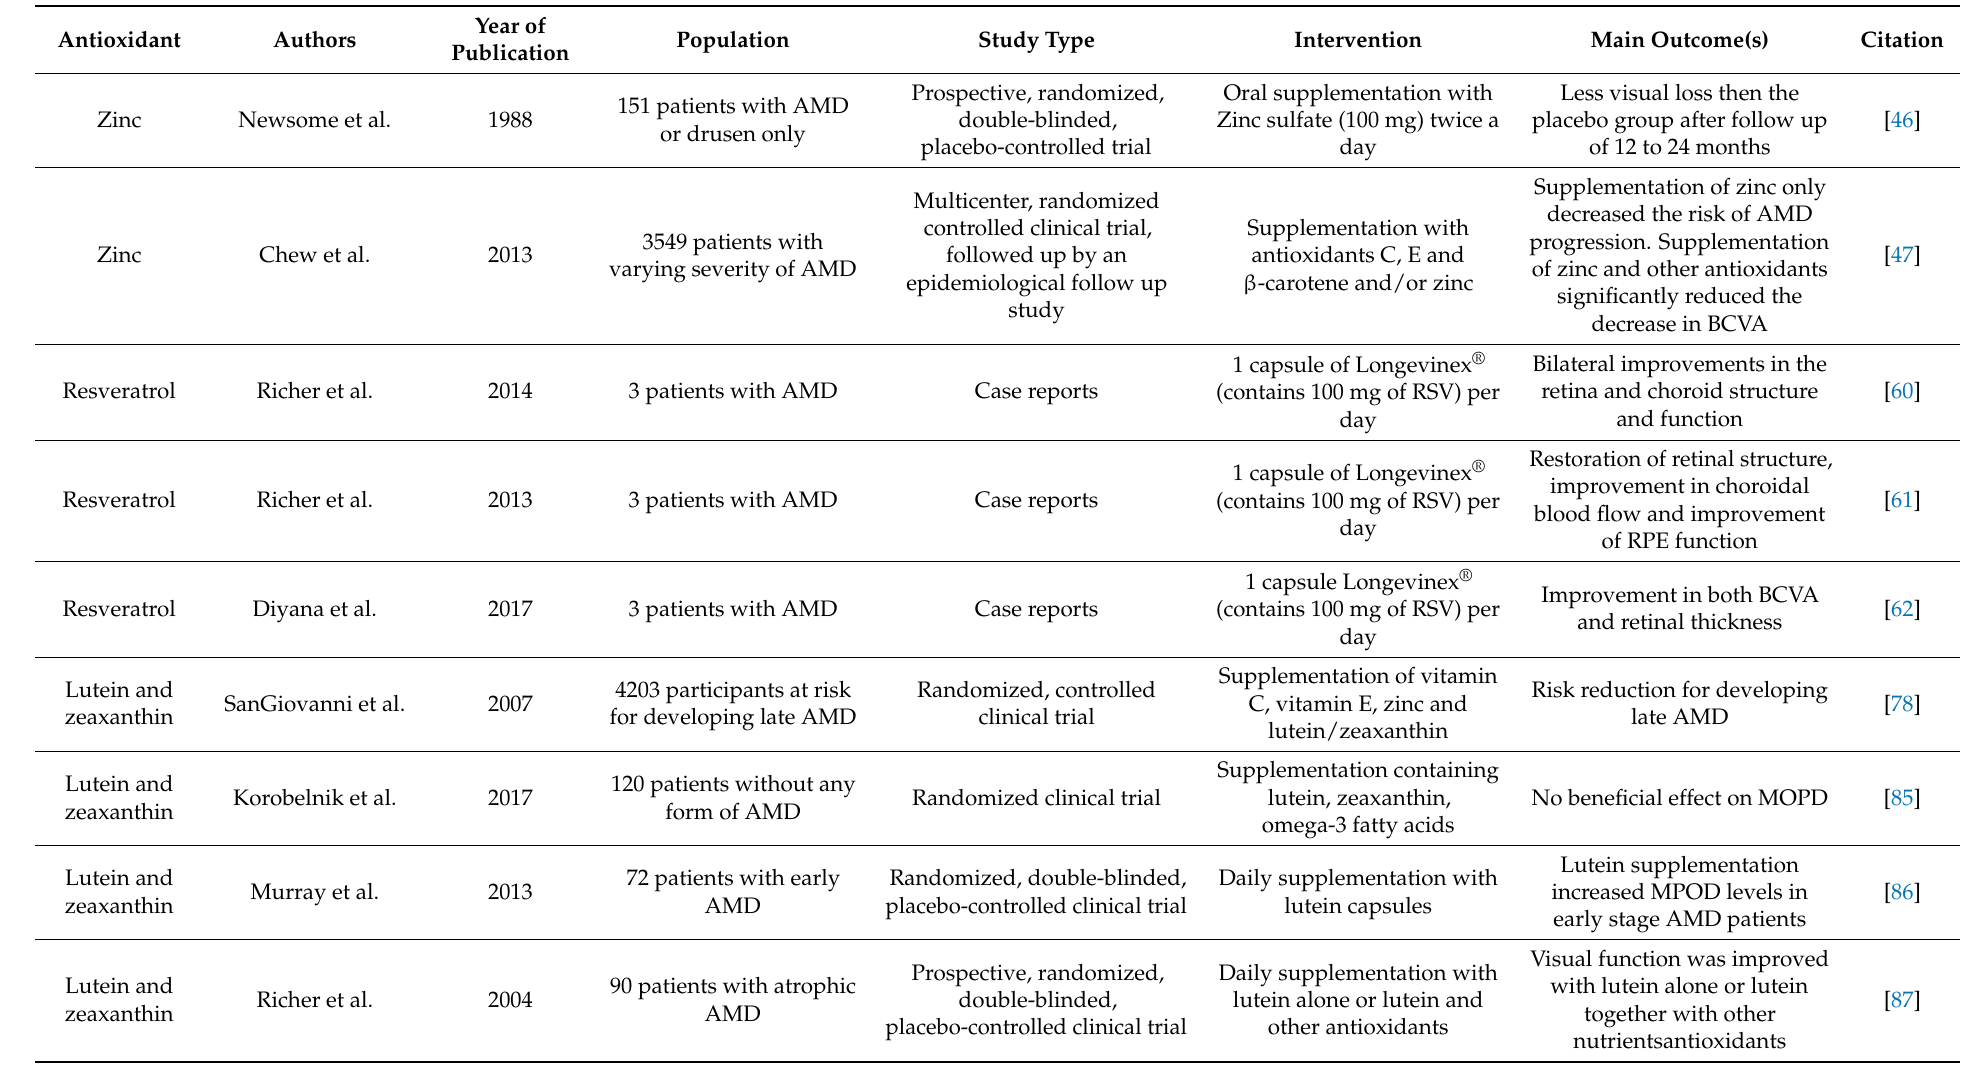
Table 1. The effects of antioxidant supplementation on the incidence and progression of AMD in clinical trials and case